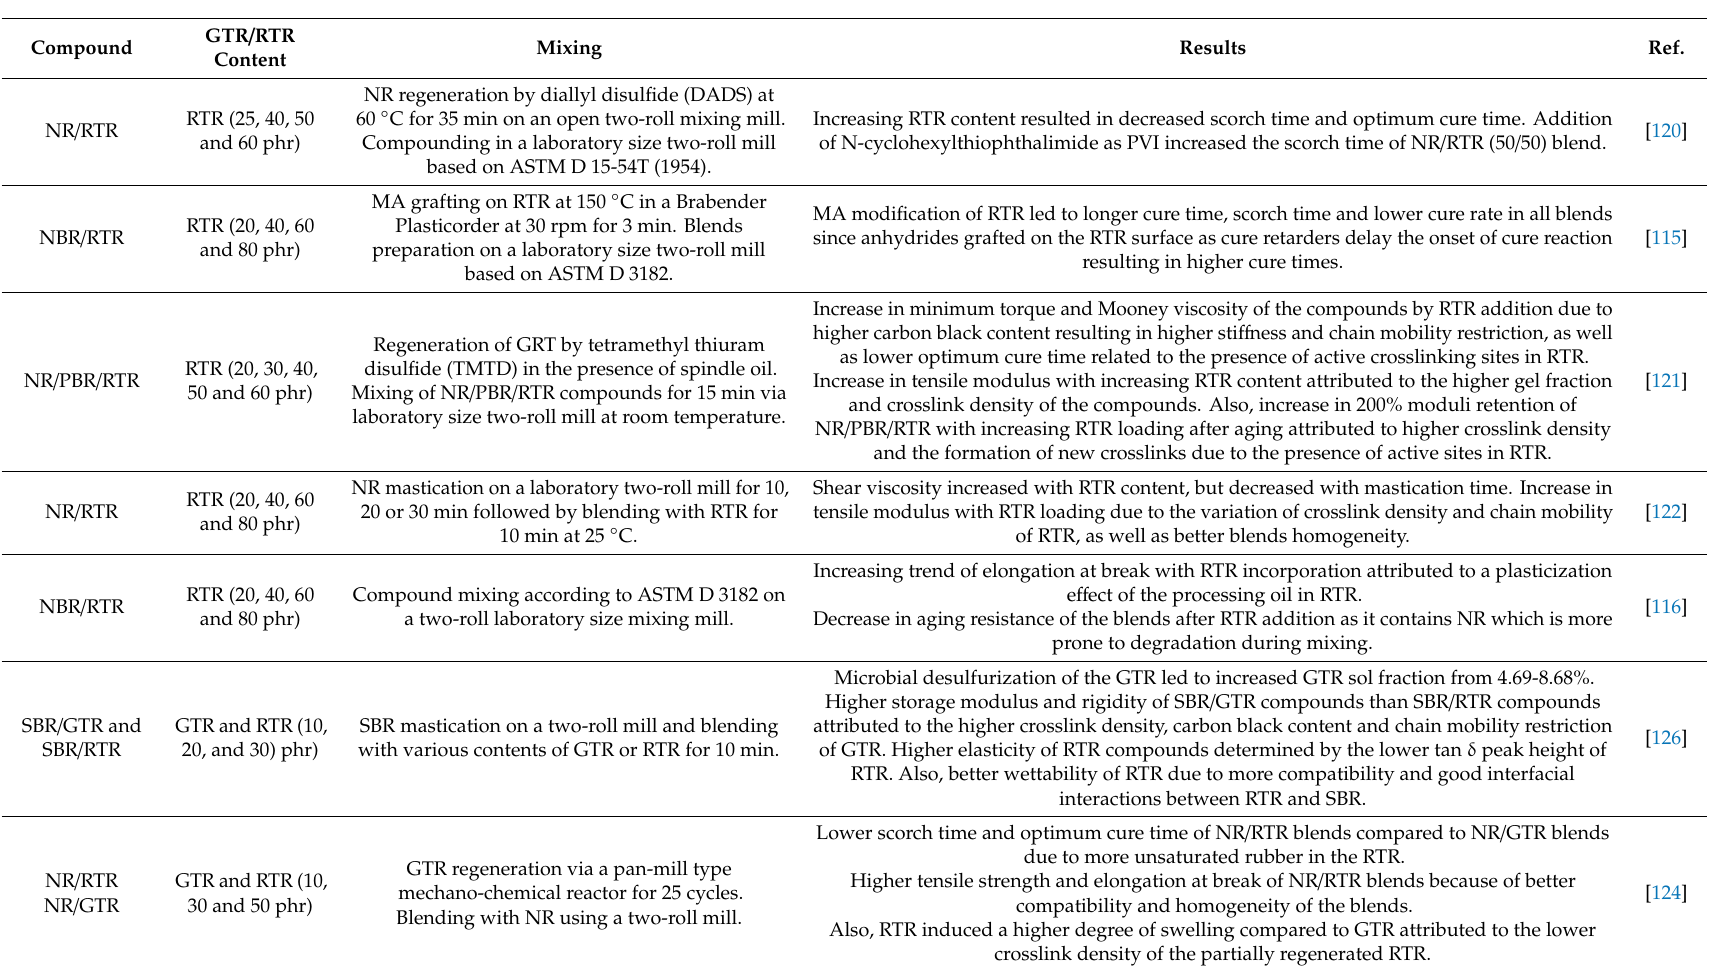
Table 8. E ff ects of GTR / RTR treatment, composition, regeneration, and compounding on the properties of rubber